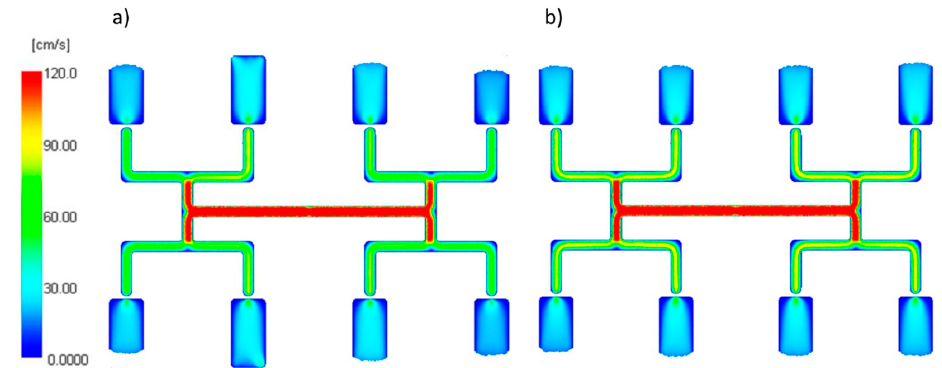
Figure 17. An effect of the thermal diffusivity α on the mass filling imbalance factor I m at various injection rates (Low = 5 cm 3 /s, High = 500 cm 3 /s).